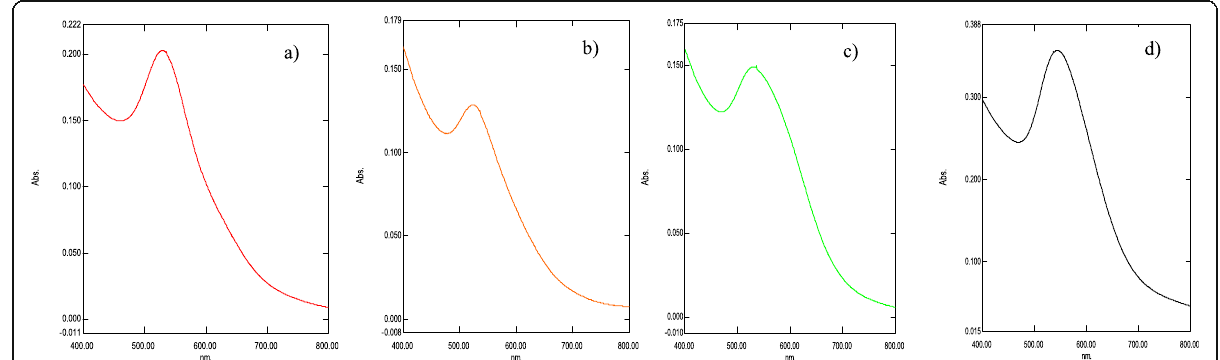
Fig. 3 a – d UV absorbance spectrum of AuNPs synthesized by A. muricata peel at 10 − 1 ( ƛ max − 529 nm), A. muricata pulp at 10 − 1 ( ƛ max − 525 nm), A. muricata peel at 10 − 3 ( ƛ max − 520 nm), A. muricata pulp at 10 − 3 ( ƛ max − 543 nm). The peak confirms the formation of